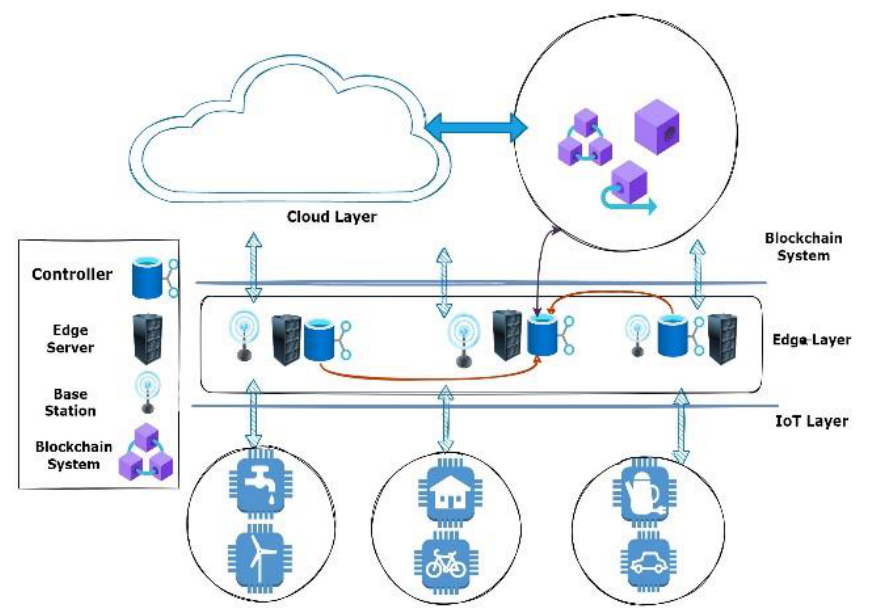
Figure 2. The DO 2 QIEO network scenario’s architecture, which includes a cloud, edge, and blockchain system. Table 2. Notations List.